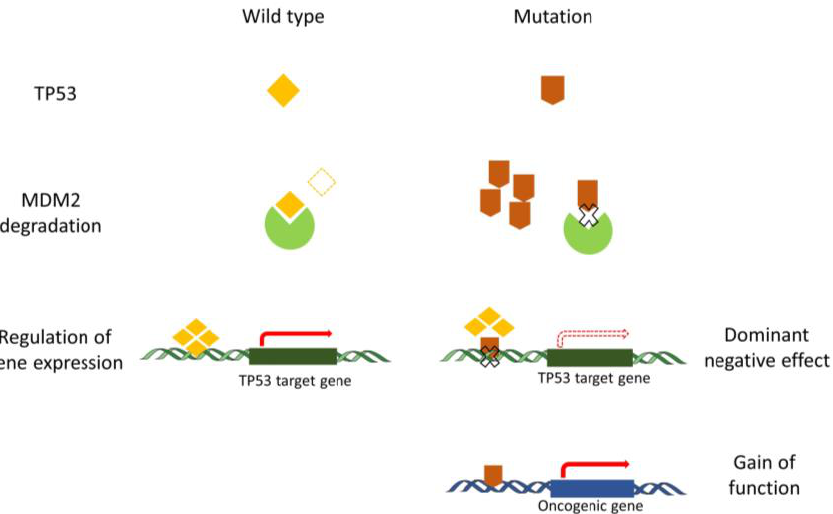
Figure 1. The anomalous function of mutant TP53 compared to the wild-type TP53. Regular degradation of TP53 is fine-tuned in the cell in order to modulate the steady-state level of TP53. Degradation of wild-type TP53 is orchestrated by MDM2 and controls the level of activation of different TP53 target genes. Mutant TP53 proteins are not appropriately degraded by MDM2 and exert a dominant negative effect by preventing wild-type P53 from binding to the regulatory regions of TP53 target genes. Mutant TP53 proteins also play a gain-of-function role that is considered